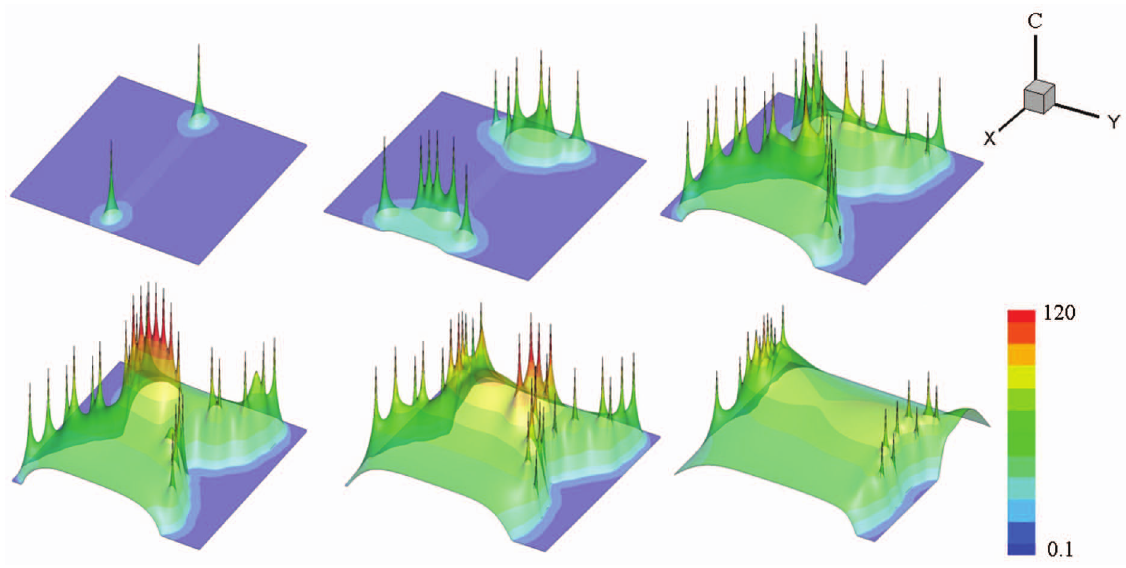
Figure 4. Snapshots of Ca 2 z waves collision. Snapshots are taken at 10, 70, 110, 120, 130 and 150ms (left to right, top to bottom). The value of parameters are b ~ 2 : 25 , I CRU ~ 5p A and l x ~ 2 : 0 m m . The concentration is from 0 : 1 m M to 120 m M .